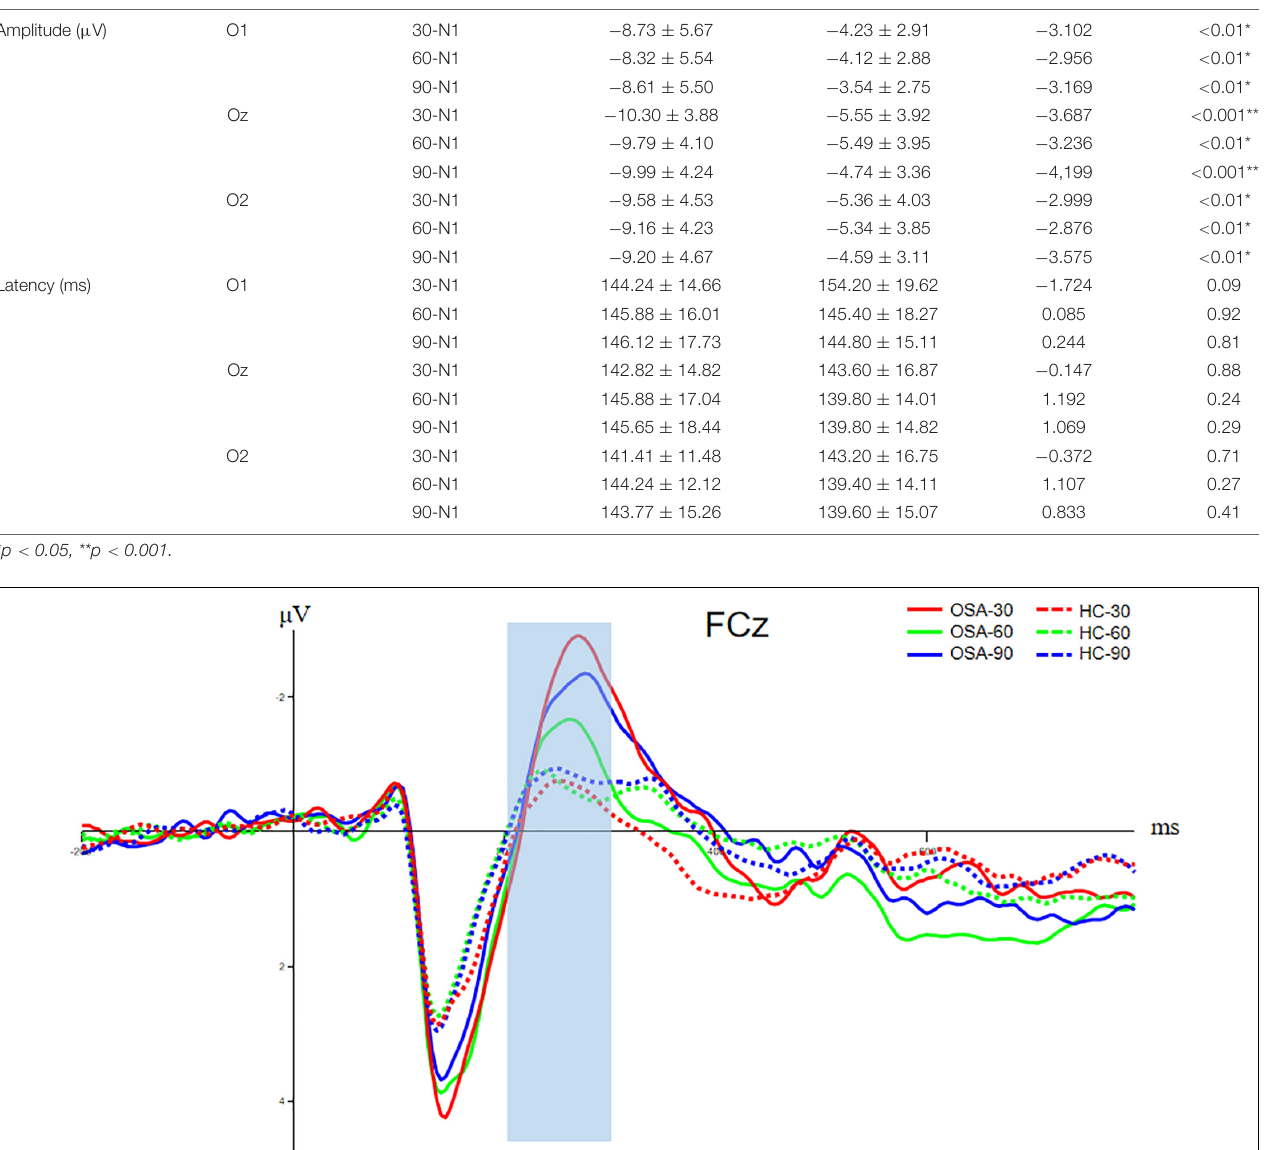
time. The physiological stress response is regulated mainly by the hypothalamus-pituitary-adrenal cortex axis (HPA axis) and nocturnal apnea affects not only the HPA axis and sympathetic nervous system but also the higher cortex of the brain. This leads to slower behavioral response and an insufficient number or intensity of neurons activated at the cognitive